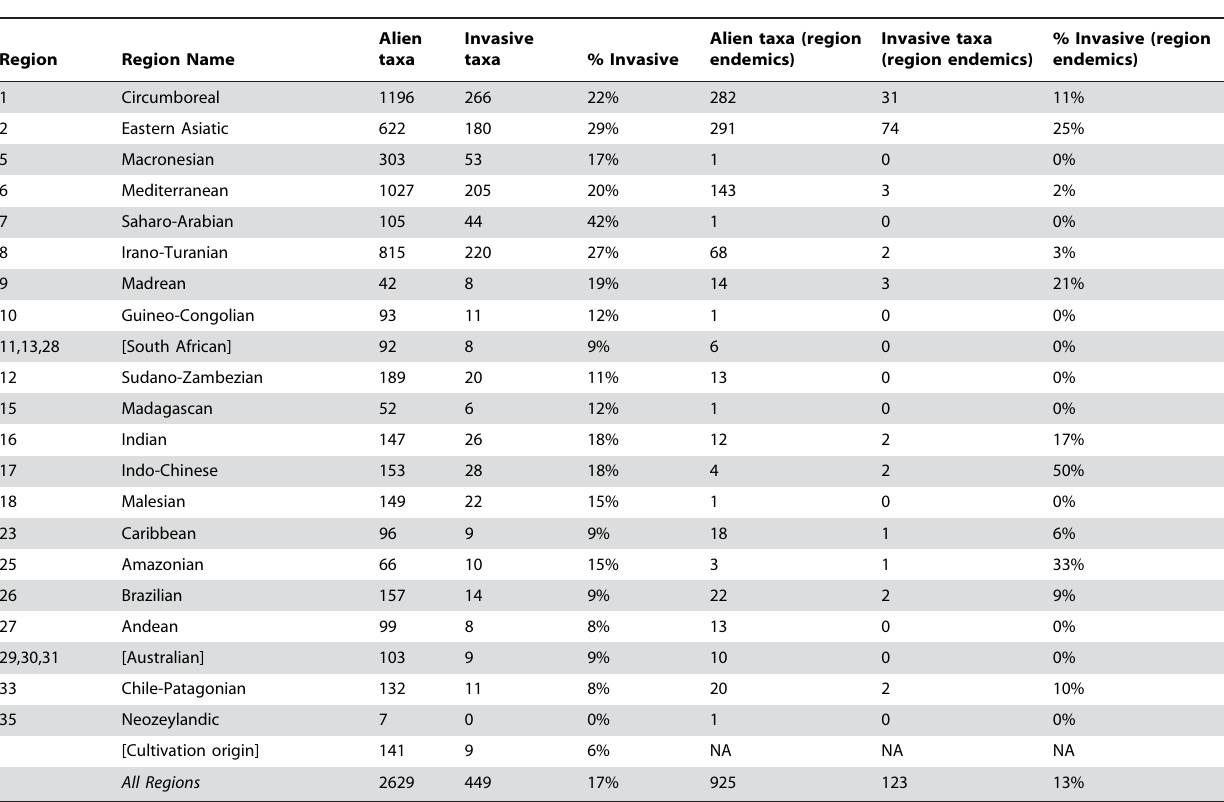
Table 2. Eastern U.S. alien and invasive floras categorized by global donor floristic regions [27].